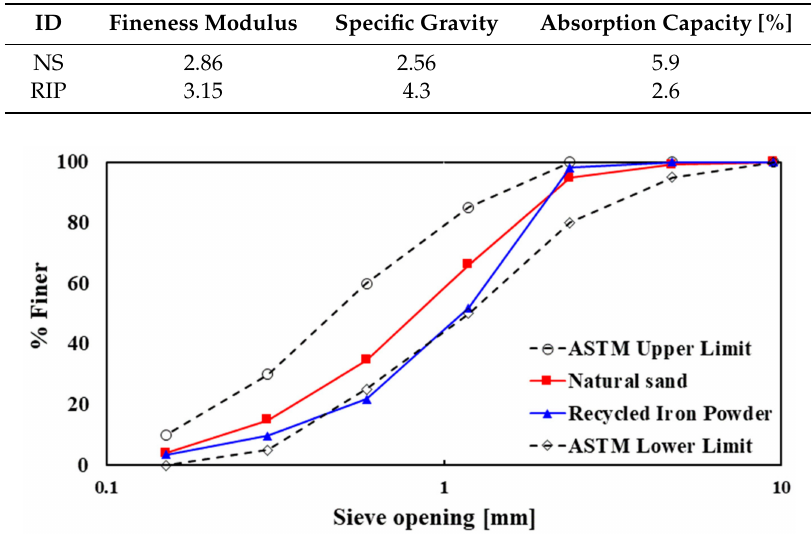
Figure 2. Grading curve of natural sand (NS) and recycled iron powder (RIP), and comparison with the upper and lower limit recommended in the ASTM C33 standard [24].